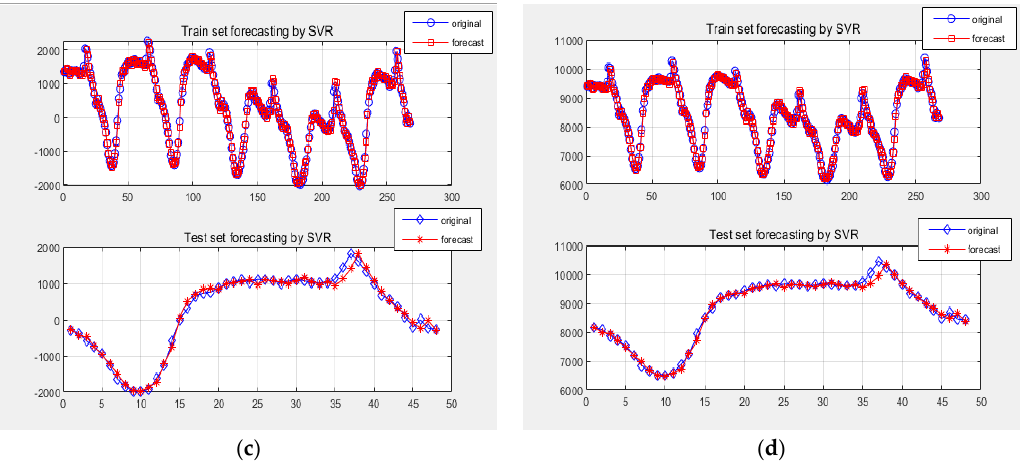
Figure 4. Comparison the forecasting results for different defined items by the SVR-PSO model (the small sample; one-day ahead forecasting on 8 May 2007). ( a ) Item A: the random term + the middle term; ( b ) Item B: the middle term + the trend (residual) term; ( c ) Item C: the middle term; ( d ) Item D: A + B − C (all IMFs, i.e., complete decomposed effects).